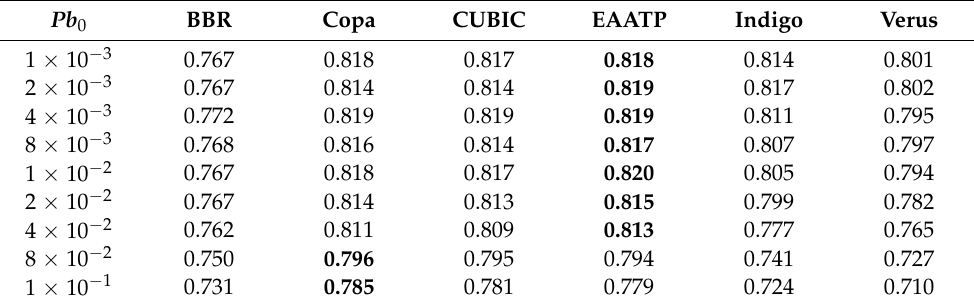
Table 3. Best STR achieved by each transport protocol in the “7 redundant sensors × 8 clusters” case. The best STR for each Pb 0 is highlighted in bold. Pb 0 BBR Copa